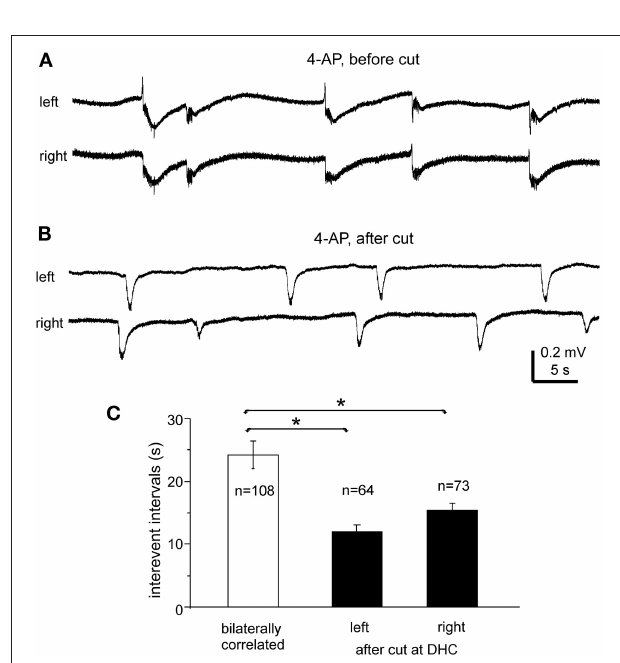
FIGURE 6 | Bilateral interictal potentials observed before and following a cut at DHC. (A,B) A bilateral hippocampal slice obtained from a 22-day-old mouse. Self-sustained interictal field potentials were induced by 100 µ M 4-AP. Representative events were collected before (A) and following a cut at the DHC (B) and illustrated after a low-pass filter (200Hz). (C) Interevent intervals (mean and SE) of interictal field potentials measured from bilaterally correlated events (5 slices) and from independent left and right hippocampal events after the DHC was cut. *bilaterally correlated events vs. independent left or right events, p < 0.05, Mann–Whitney U